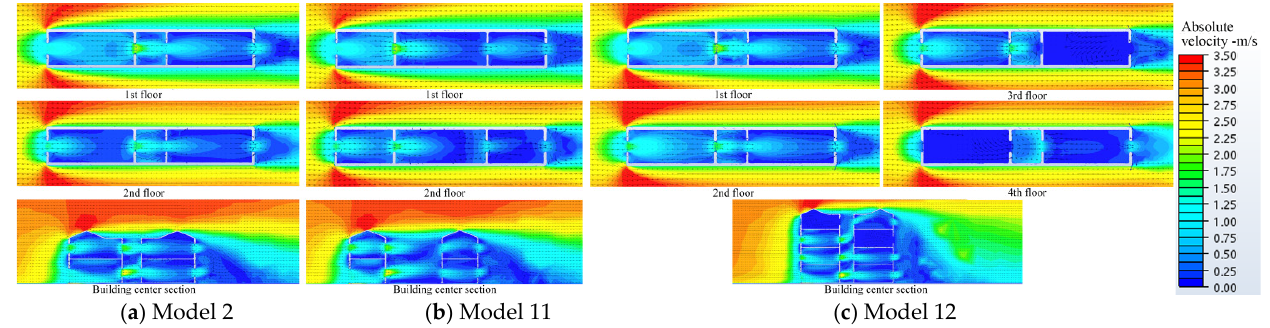
Figure 12. Simulated spatial distributions of V a in Models 2, 11, and 12 at 12:00 at 1.2 m height on each floor.